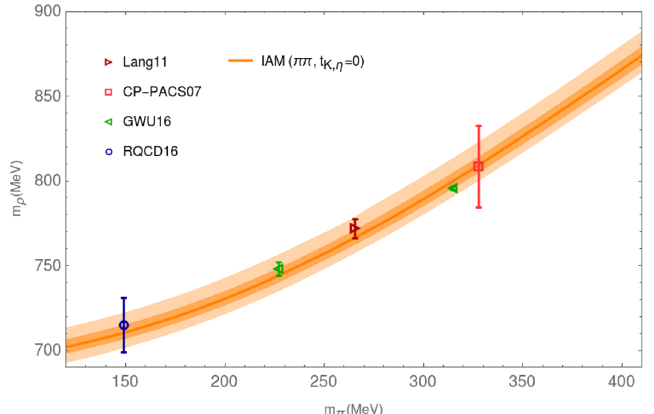
Figure 39 . Result for the (cid:26) meson mass when interacting terms involving kaons and etas, t K;(cid:17) , are set to zero as explained in the text, in comparison with N f = 2 lattice data.